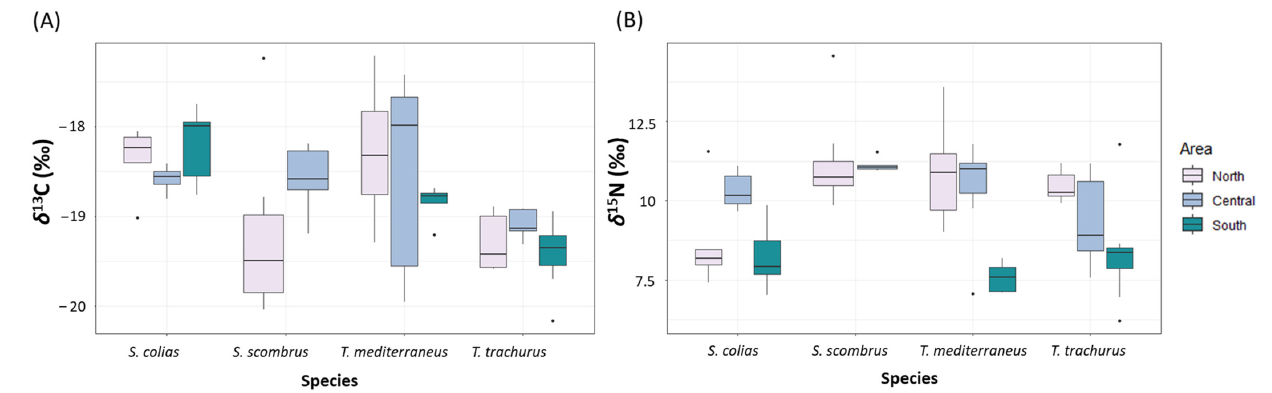
Figure 5. Boxplot showing the values of ( A ) δ 13 C (‰) and ( B ) δ 15 N (‰) measured in the four “ancil- lary” species captured in the North, Central and South Adriatic Sea. “ancillary” species captured in the North, Central and South Adriatic Sea.